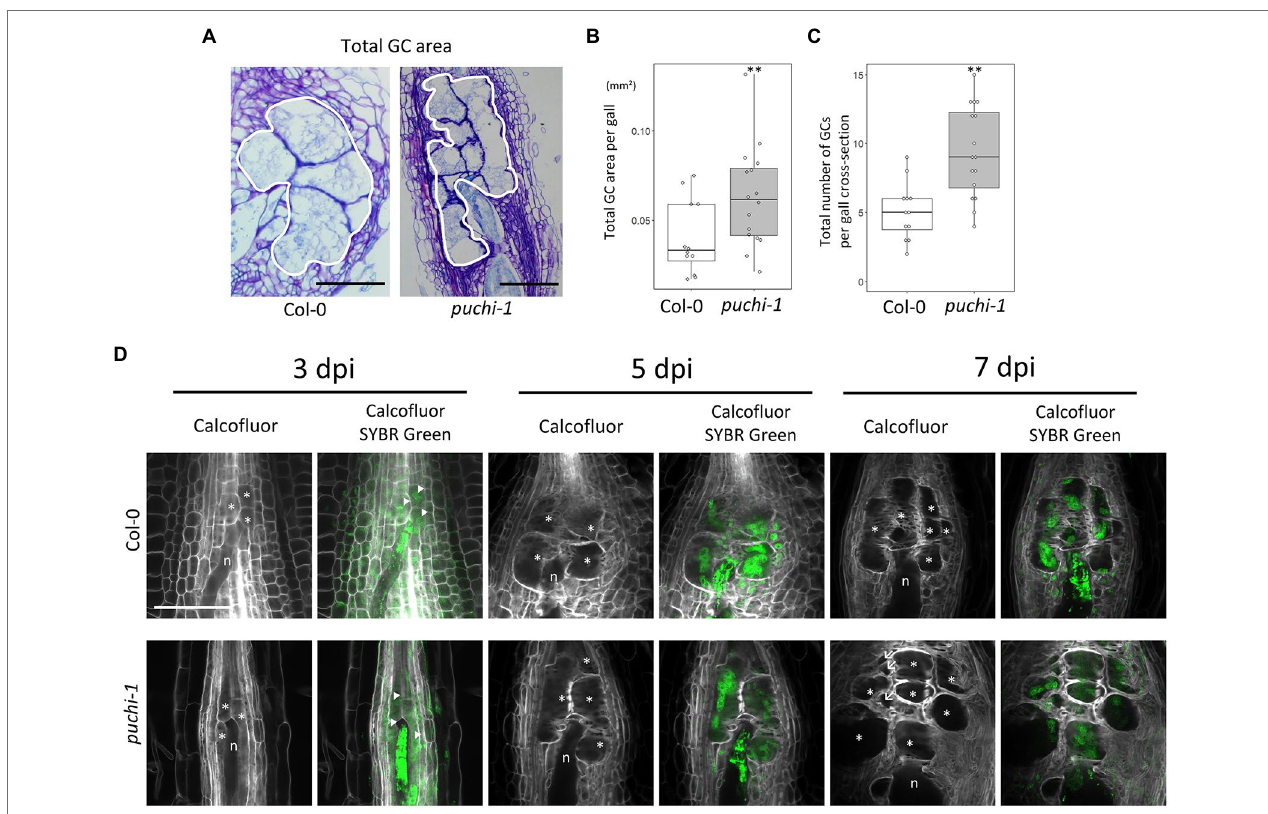
FIGURE 4 | Development of WT and puchi-1 GCs. (A) Areas occupied by GCs in the WT and puchi-1 galls, as outlined with white borders. (B) Box plots of the total area occupied by GCs in WT and puchi-1 galls at 14 dpi. (C) Box plots of the number of GCs within the area occupied by GCs in cross-sections of WT and puchi-1 galls at 14 dpi. ** p < 0.01, Brunner-Munzel test. (D) Confocal microscopy images of WT and puchi-1 galls stained with Calcofluor White for cell walls and SYBR-Green for nuclei at 3, 5, and 7 dpi. n denotes RKNs. * denotes GCs. Arrow denotes aberrant GCs. Arrowheads denote